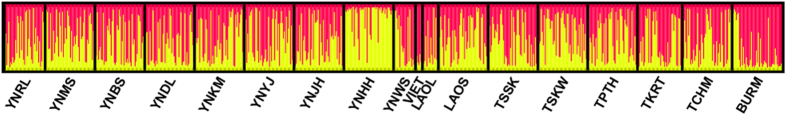
Bayesian results based on STRUCTURE among 18 populations of B.correcta at K = 2, individuals were grouped by collection site according to Table 1, each individual was represented by a vertical bar displaying membership coefficients.